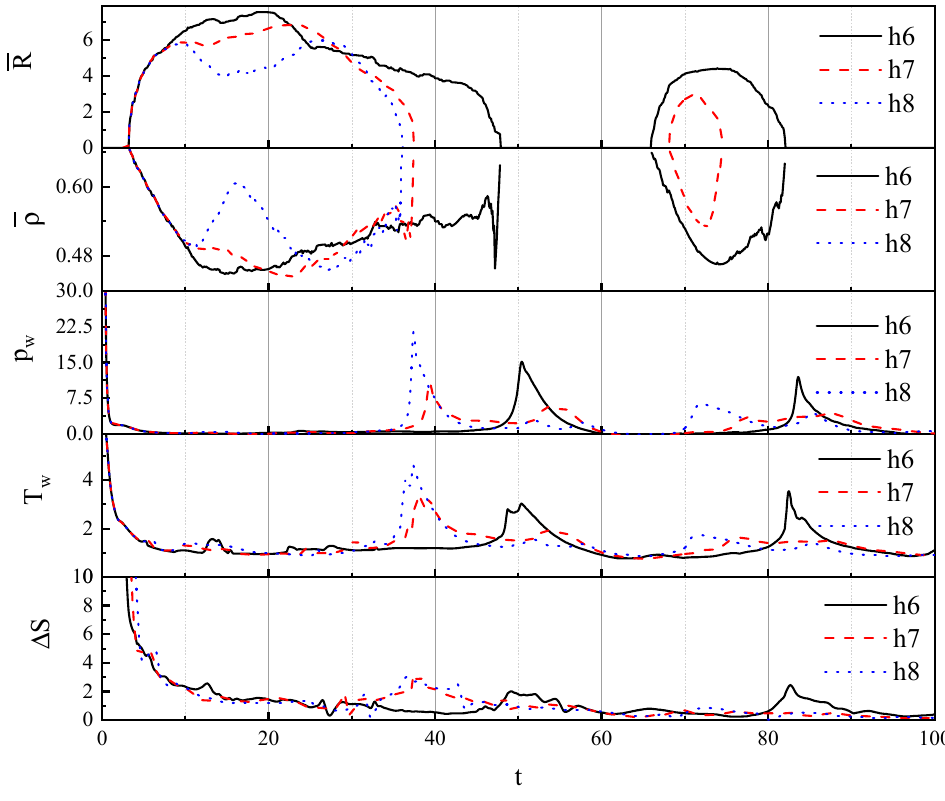
Figure 12. Average bubble radius R and entropy increase ∆ S with time.